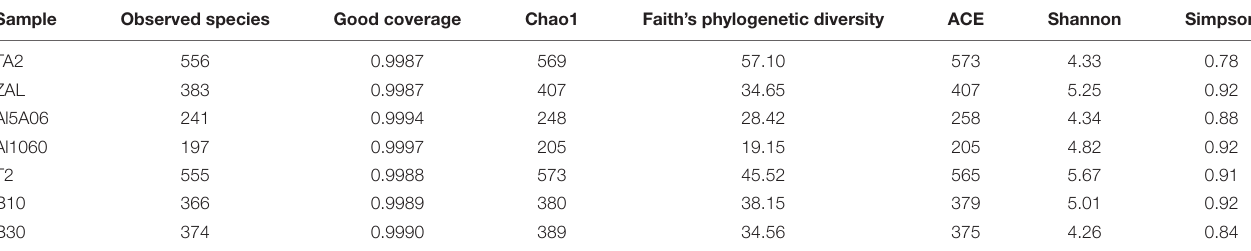
TABLE 2 | Diversity estimators for bacteria from seven metallic surface samples exposed in Yap Trench using 16S rRNA gene sequencing.